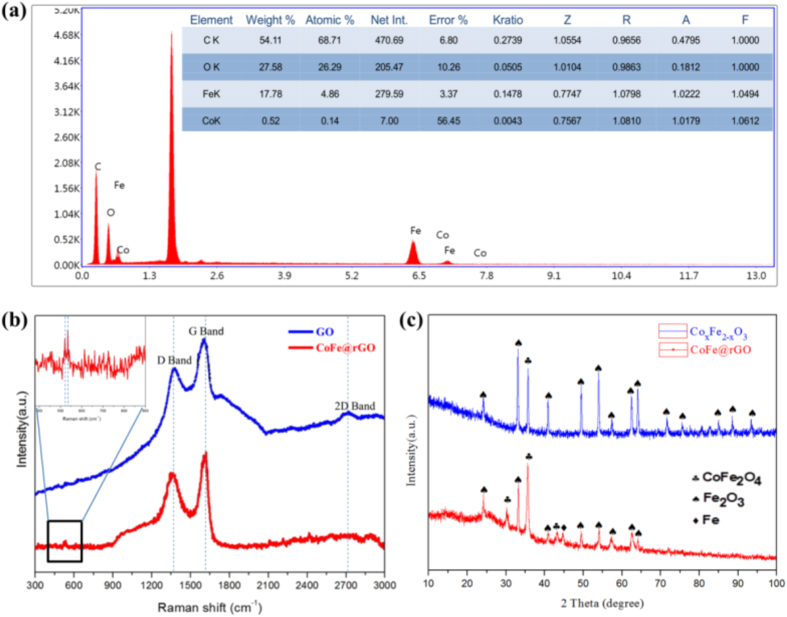
Structure characterization of CoFe2O4@rGO.(a) EDS pattern of CoFe@rGO; (b) Raman spectra of GO and CoFe@rGO; (c) X-ray diffraction pattern of CoFe@rGO.